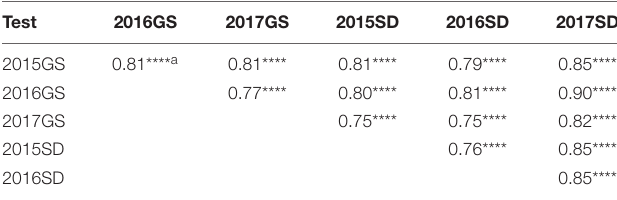
TABLE 4 | Correlation coefficients for leaf rust severities (AUDPC) of the 186 RILs of NG × BQM among the six field tests during 2015–2017 in Gansu (2015GS, 2016GS, and 2017GS) and Shandong (2015SD, 2016SD, and 2017SD).